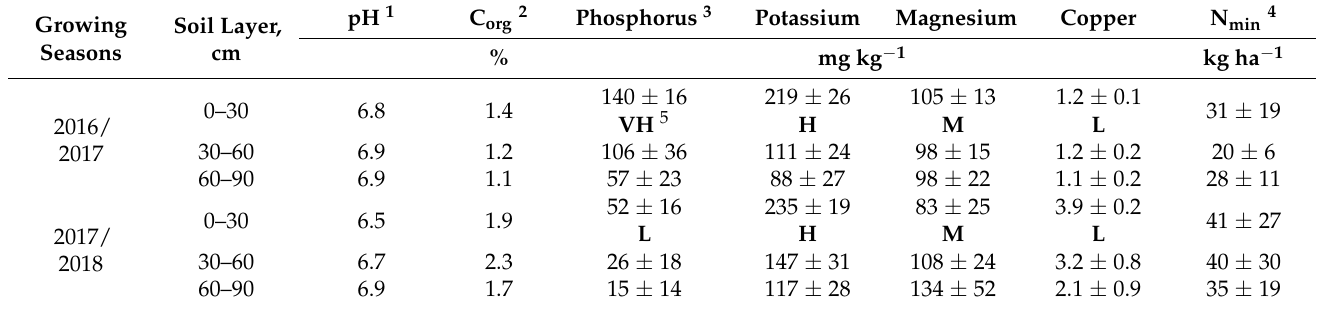
Table 1. Agrochemical properties of the soil in subsequent growing seasons.